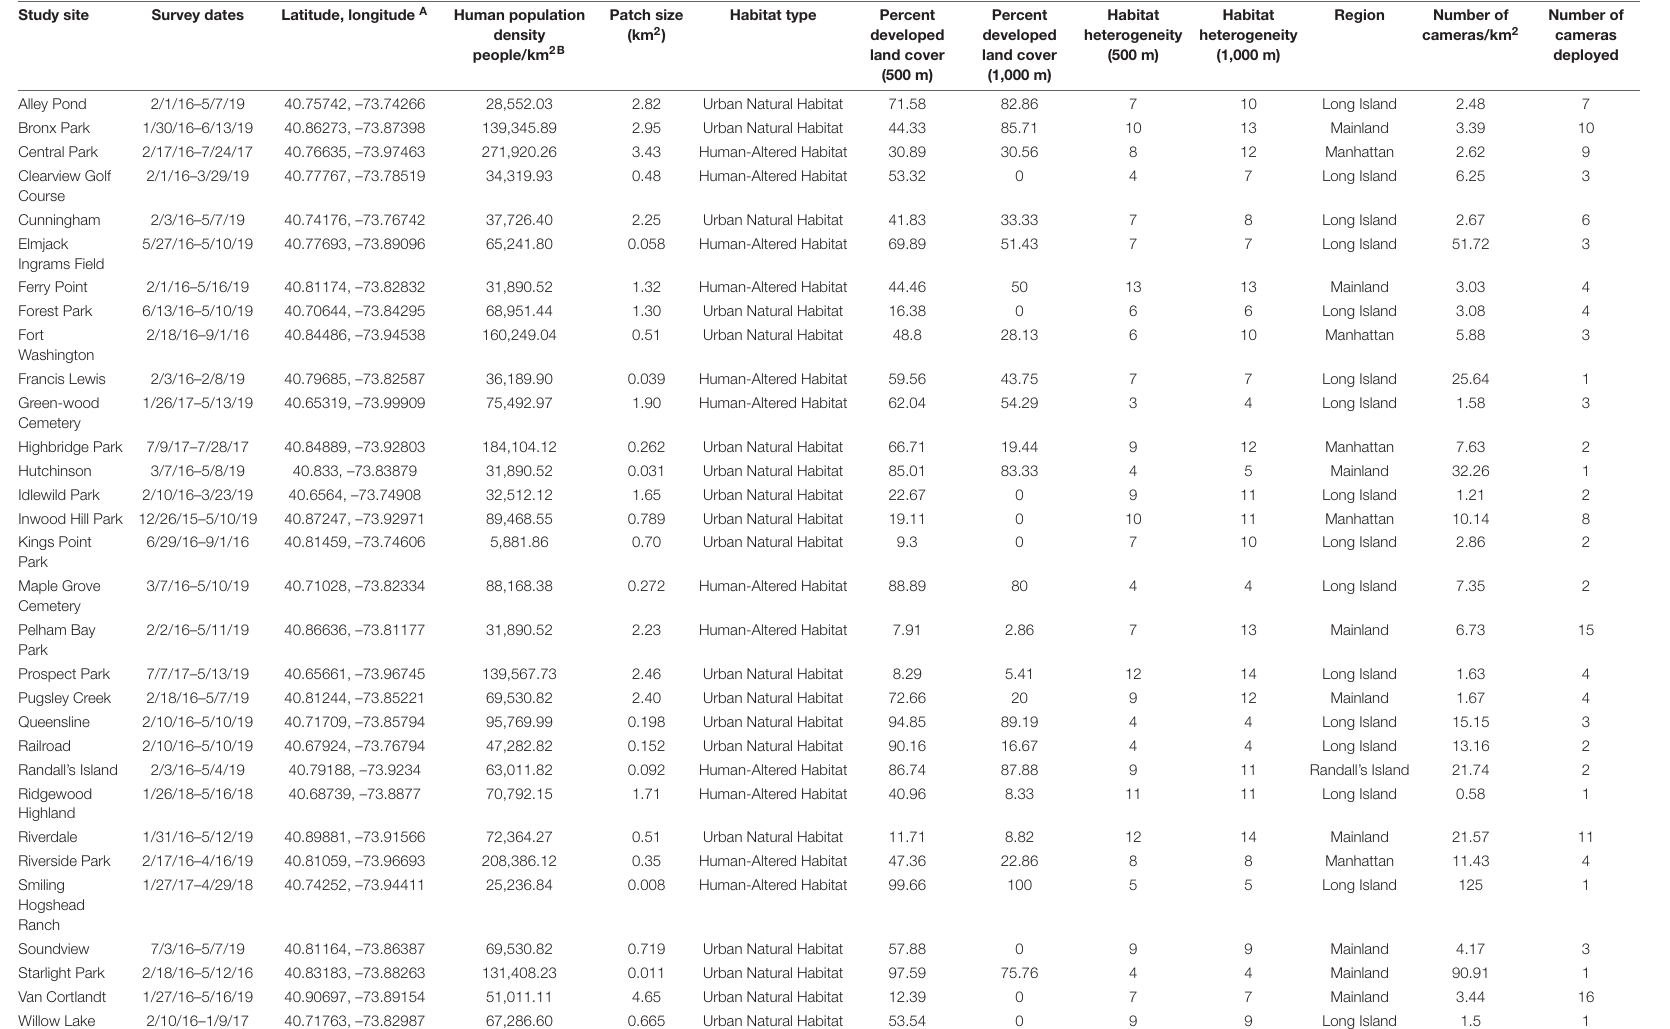
TABLE 1 | Dates, location, and characteristics of study sites surveyed